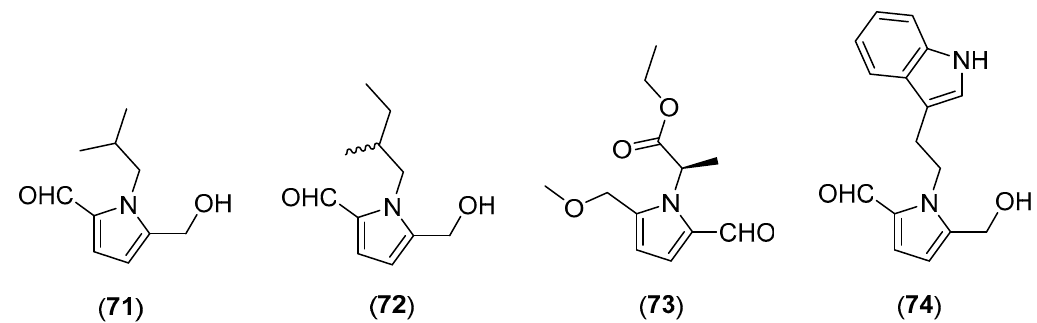
Figure 14. Chemical structures of selected compounds isolated from Phlebopus portentosus.